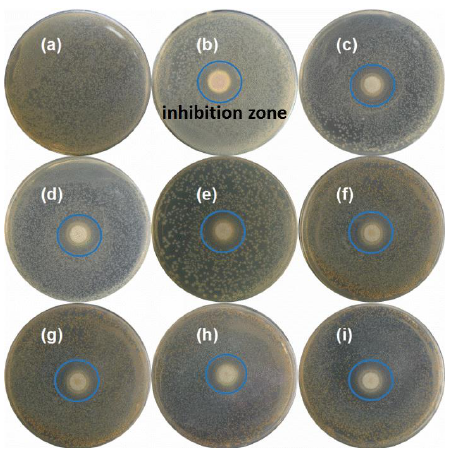
Figure 5. Bacterial inhibition test for RFA and thermally treated disks against E. coli and S. aureus . ( a ) The growth of E. coli without fly ash disk; ( b – e ) the growth of E. coli in the presence of RFA, FA700-10, FA900-10, and FA1100-10, respectively; ( f – i ) the growth of S. aureus in the presence of RFA, FA700-10, FA900-10, and FA1100-10, respectively.